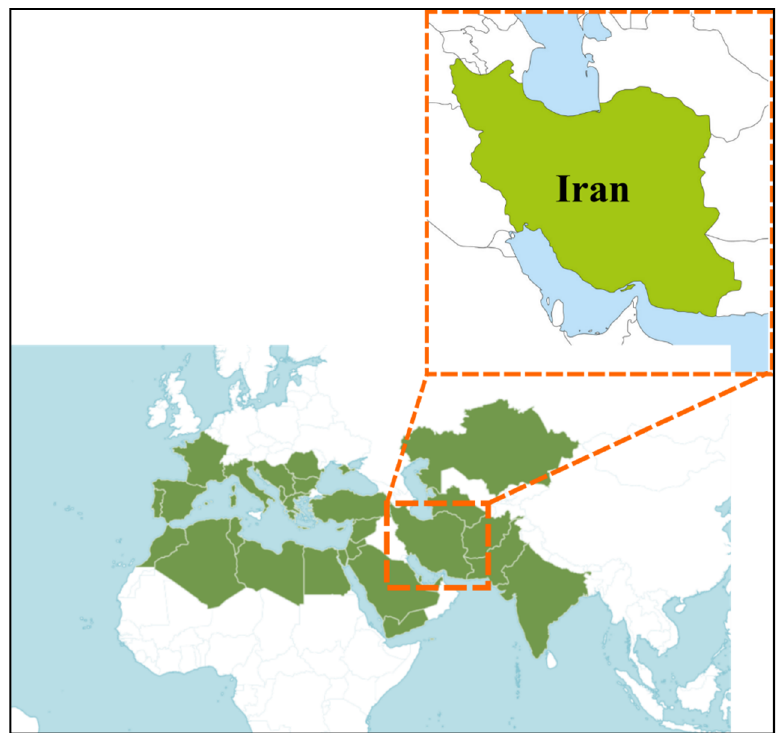
Figure 1. Potential countries for C. tinctoria cultivation [43] .